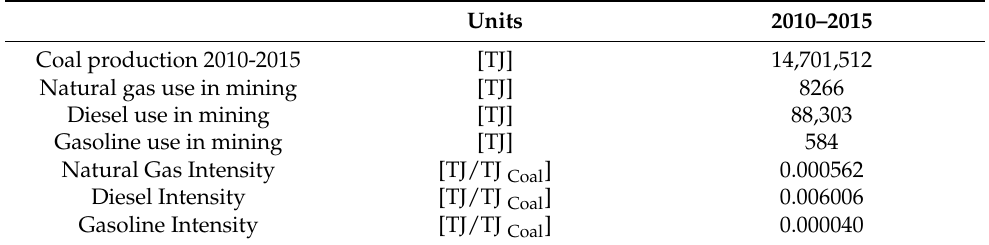
Table 9. Energy intensity in coal mining